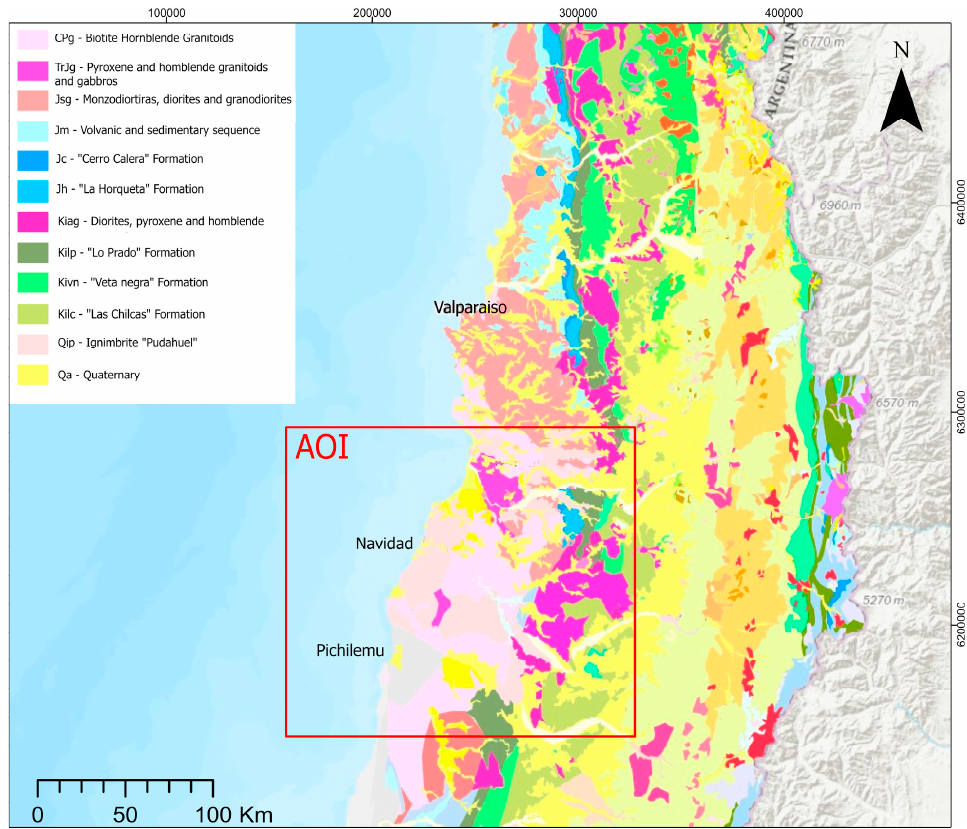
Figure 3. Simplified geological map of Chile central, with main geologic units [56]. The Paleozoic units correspond to large plutonic bodies that are distributed along the western slope of the Cordillera de la Costa. Its lithology consists mainly of tonalites, granodiorites and monzogranites from amphibole and biotite. In addition, metamorphic rocks are found, of plutonic protolith with tectonic foliation [55]. Triassic intrusive rocks occur in the SW zone of the study area. The lithology consists mainly of gneissic diorites, amphibolites, quartz diorites, and partially metamorphosed gabros; they present ductile gneissic foliation, with a NW orientation keeping towards the south. The most voluminous intrusive units correspond to the Jurassic granitoids. The lithology varies between granite, tonalite, granodiorite, and gabros to a lesser extent; towards the westernmost sectors there is a ductile NW-SE foliation; towards this, foliation decreases progressively. Intrusive Cretaceous outcrops are on the eastern slopes of the Cordillera de la Costa. They are plutonic granitoids that intrude both Jurassic intrusives and volcanic and sedimentary rocks of Jurassic and Cretaceous ages [57]. The Cretaceous units correspond to the Lo Prado, Veta Negra, and Las Chilcas forma- tions. The first is arranged in a concordant way on the Horqueta Formation, and consists largely of siliceous volcanic rocks (rhyolites and ignimbrites) [58,59], with volcanic rocks of a maphic character towards the roof of the sequence. The Lo Prado Formation is covered by the Veta Negra Formation, which is made up of a large volume of basaltic to andesitic– basaltic volcanic rocks. The Veta Negra Formation underlies the Las Chilcas Formation in angular unconformity, which corresponds to a volcanic and continental sedimentary sequence, approximately 3000 m thick [60,61]. The Las Chilcas Formation underlies the Lo Valle Formation in unconformity of erosion [57], which corresponds to a pyroclastic sequence of andesitic to rhyolitic composition, with intercalations of lavas and continental sedimentary rocks reaching 1800 m thick